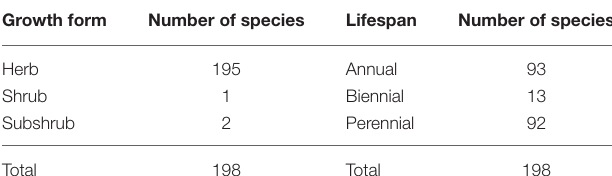
TABLE 5 | Growth form and lifespan of species.